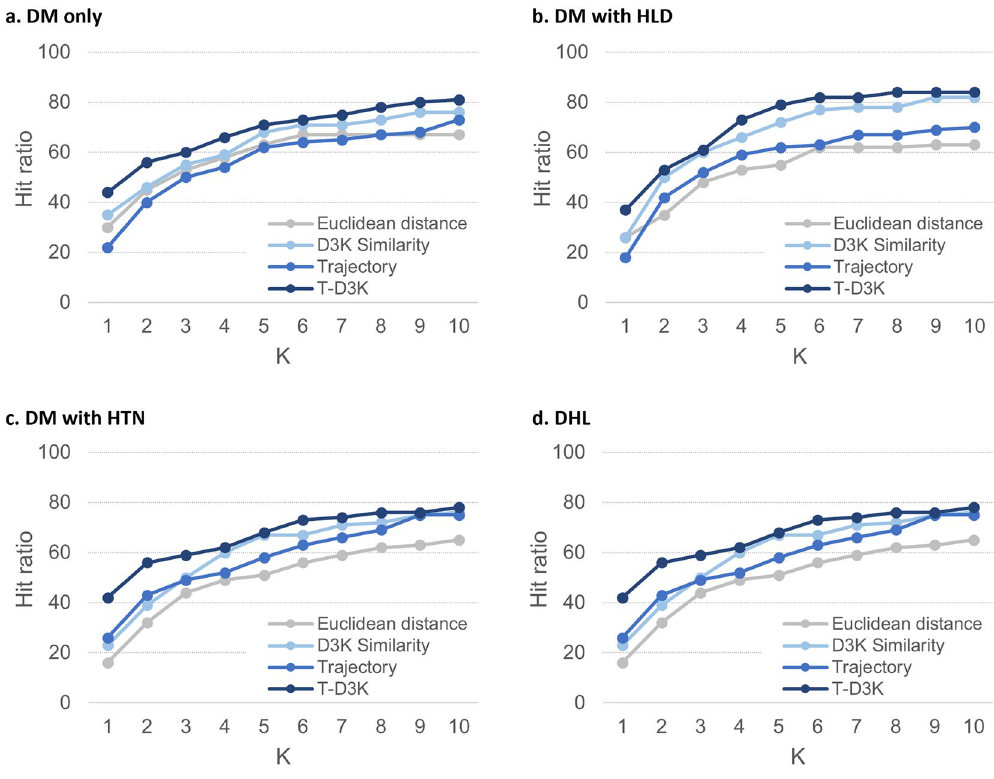
Figure 1. Hit ratio for the four groups of